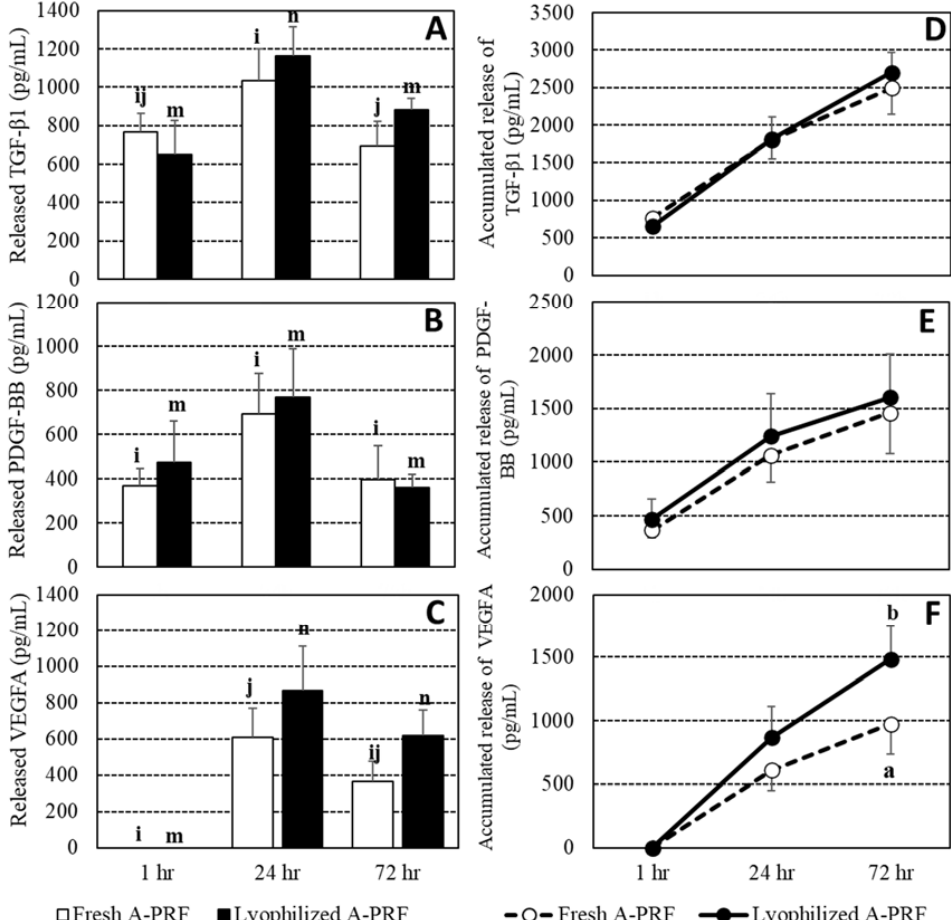
Figure 2. Releases and accumulated releases, as bar and line charts, respectively, of growth factors, including transforming growth factor-beta1 (TGF- β 1) ( A , D ), platelet-derived growth factor-BB (PDGF-BB) ( B , E ), and vascular endothelial growth factor-A (VEGFA) ( C , F ), between the fresh and lyophilized advanced platelet-rich fibrin A-PRF at 1 h, 24 h, and 72 h. I,j and m,n : different letters indicating differences between time points within the fresh A-PRF and the lyophilized A-PRF, respec- tively. a,b : different letters indicating differences between the fresh and the lyophilized A-PRF at a specified time at p <